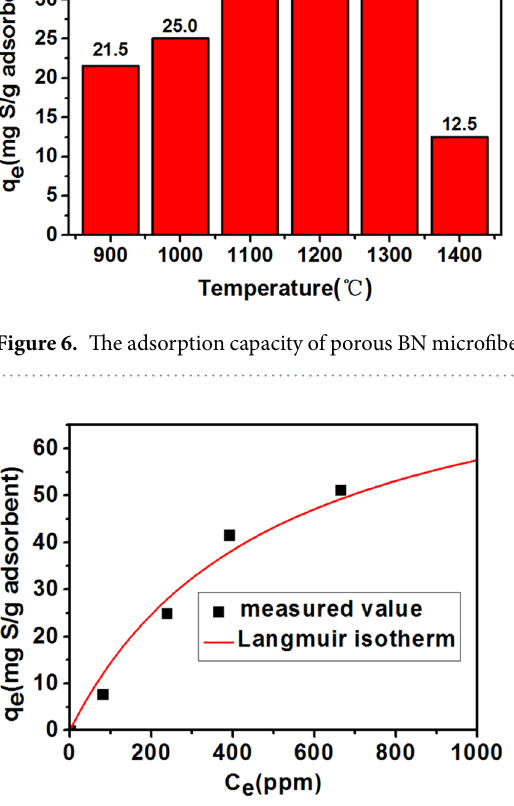
Figure 7. Langmuir isotherm of DBT adsorption porous BN fibers.